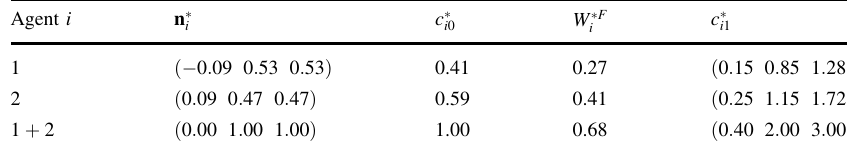
Table 4 Summary of agents’ portfolios, consumption and wealth in the tax economy Agent